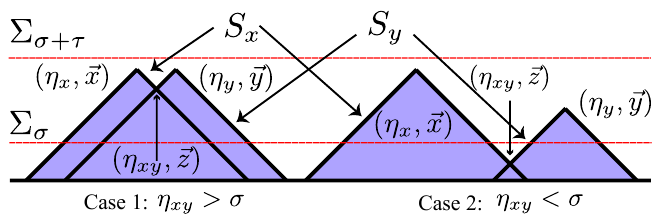
Figure 3 . Determination of the upper limit of r in the integral eq. (4.12). ( η x , ~x ) and ( η y , ~y ) denote two spacetime points, S x , S y are their past cones, Σ σ and Σ σ + τ characterize two hyperplanes where η = σ and η = σ + τ respectively. Case 1 corresponds to the situation where η xy > σ , under such a circumstance, the bubble can nucleate after the beginning of the phase transitions and influence two spacetime points x, y . Case 2 corresponds to the situation where η xy < σ , so the bubble must nucleate before the start of the phase transitions which is